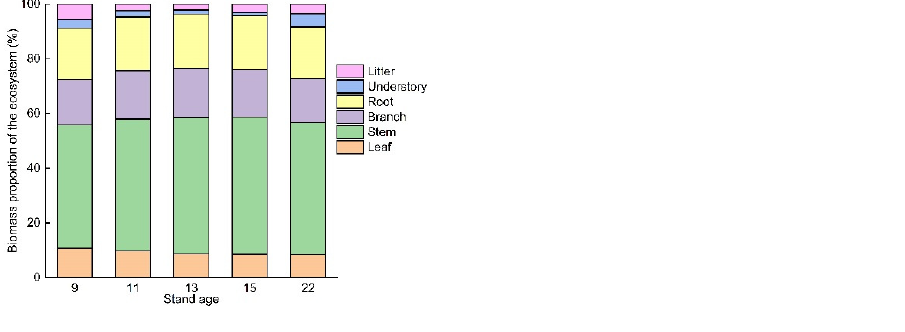
Figure 5. Biomass proportion of the ecosystem from leaf, stem, branch, root, understory and litter in the 9-, 11-, 13-, 15-, and 22-year-old T . Zhongshanshan stands.